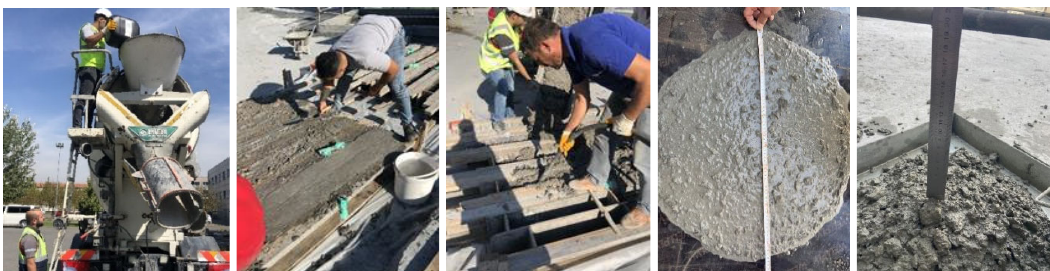
Figure 2. Fabricating of GC beams.